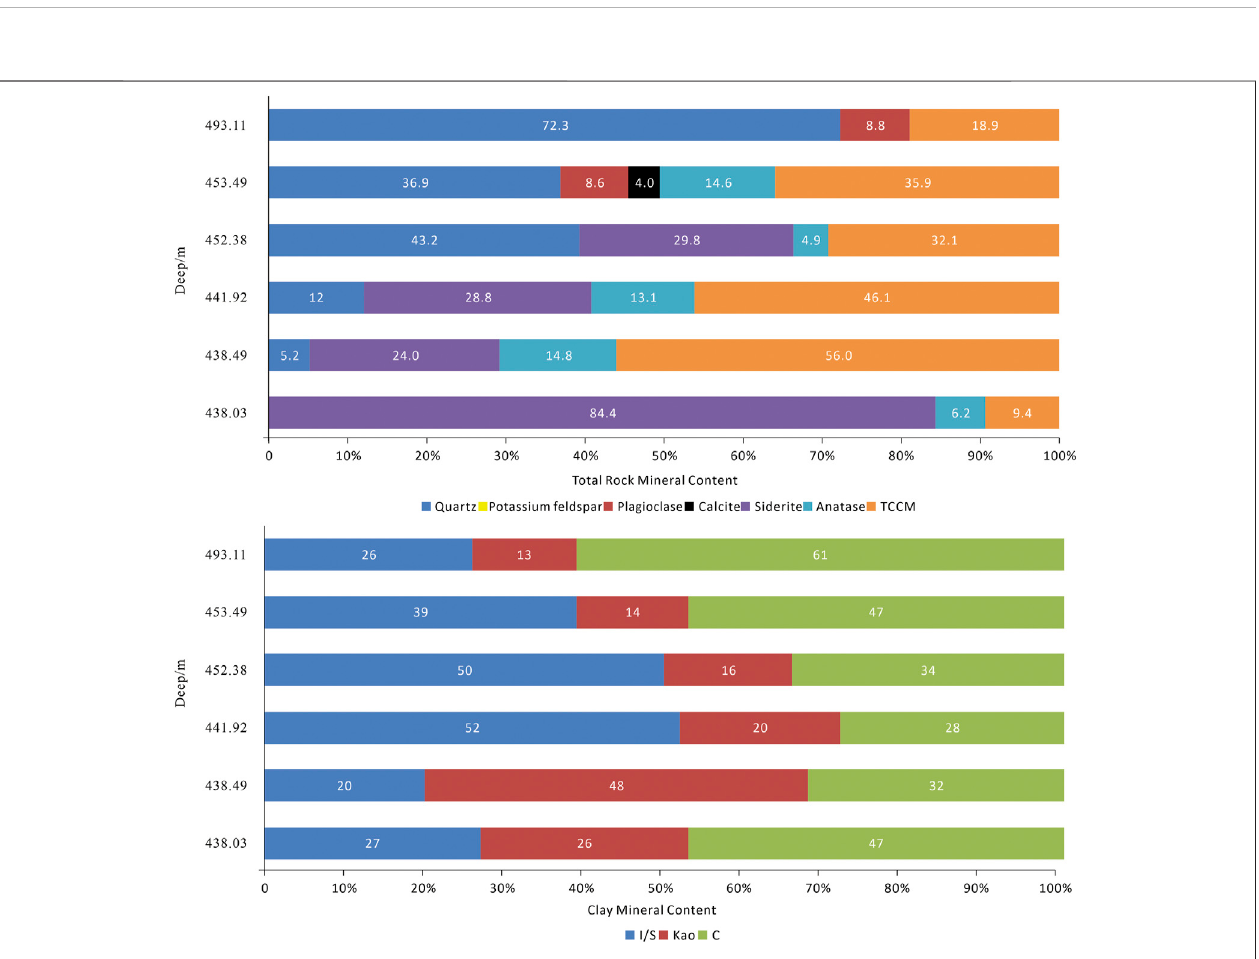
FIGURE 4 | Y4 well statistical analysis chart of whole rock minerals and clay minerals.